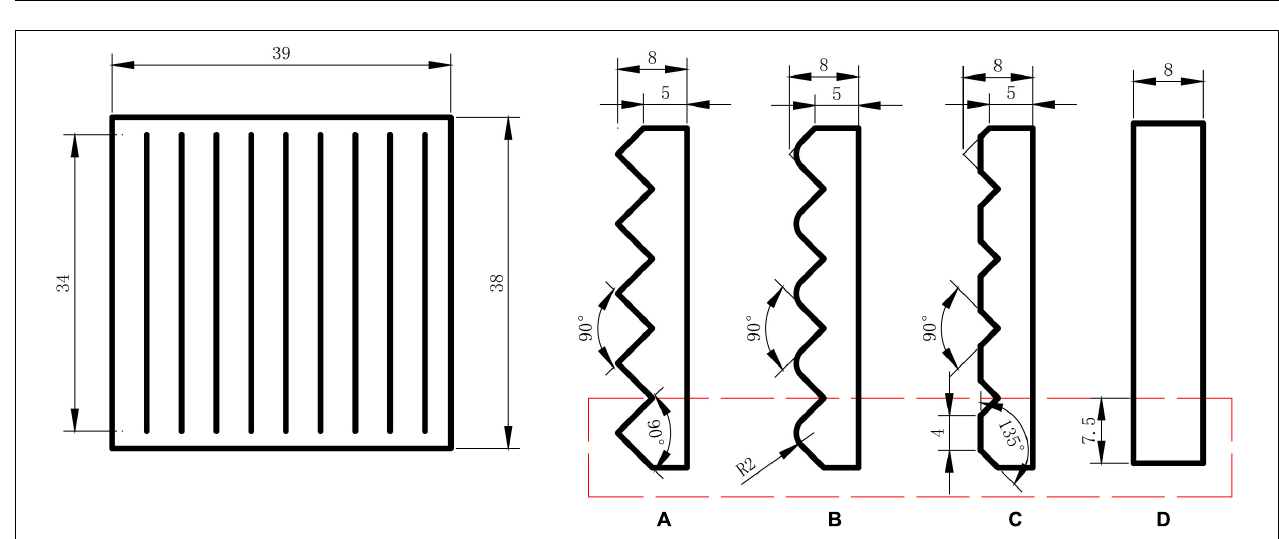
FIGURE 2 | Samples with ridged textures of (A) sharp shape, (B) round shape, (C) flat shape, and (D) smooth sample.